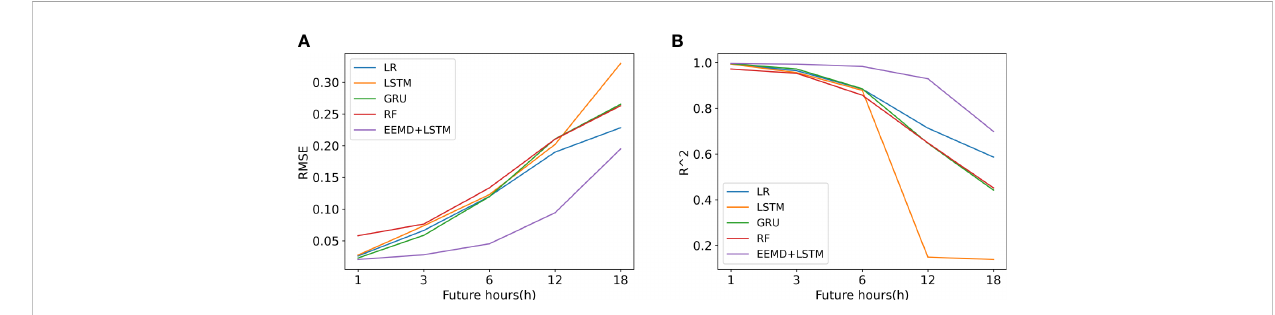
FIGURE 12 Rmse(M) And R2 Line Graphs Of The Swh Prediction Results Of Each Model For the next 1-18 hours (A) RMSE(m), (B) R2